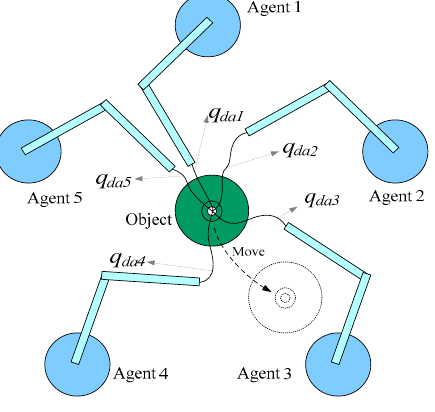
Figure 5. Multi-agent system model.